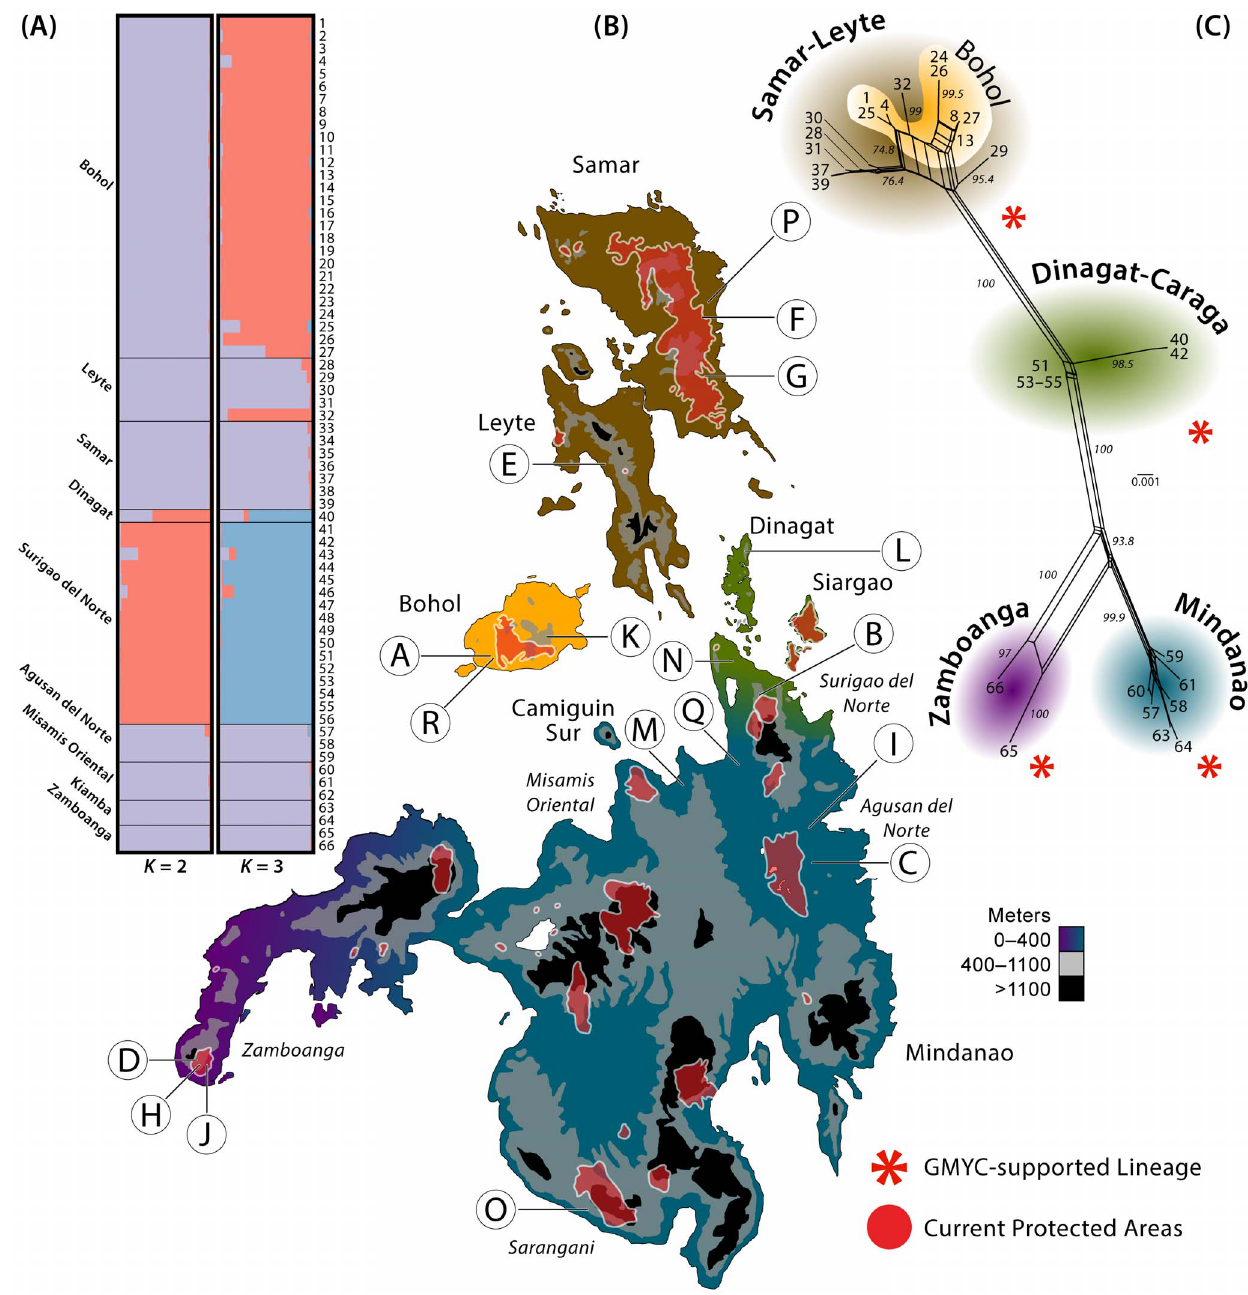
Figure 2. DISTRUCT visualization of STRUCTURE analyses (A) assigning individuals to major population groupings (genetically distinct evolutionary lineages) for Philippine tarsier demes ( K =2 and 3 populations). Mindanao faunal region (B; see Fig. 1, inset) with sampling (17 sites, 66 individuals) labeled with letters corresponding to full localities listed in Appendix S2, protected areas shaded red. SplitsTree gene network (C; numbers at internodes=ML bootstrap replicates), and results of GMYC analyses (red asterisks denote lineages delineated by the Yule-coalescent), with numbers at tips corresponding to individual samples in Structure plots (A) and cluster shading corresponding to islands on map (B).